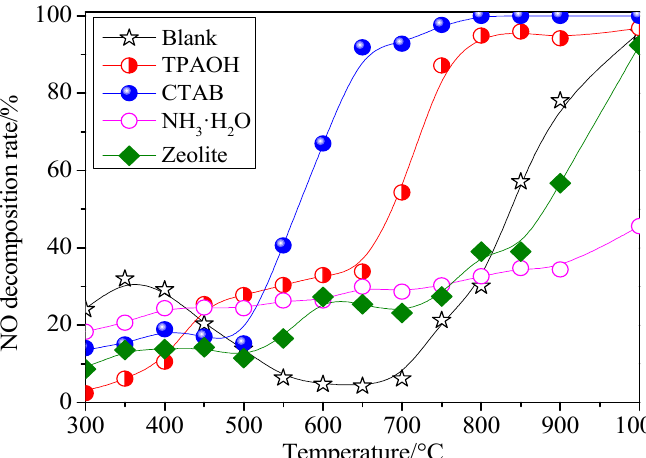
Figure 2. The effect of porous materials with different templates on the NO decomposition rate (Blank, tetrapropylammonium hydroxide (TPAOH), cetyltrimethylammonium bromide (CTAB), ammonium tetrapropylammonium hydroxide (TPAOH), cetyltrimethylammonium bromide (CTAB), hydroxide (NH 3 ·H 2 O), and Zeolite were used, respectively, instead of the Cu-Al/SiO 2 porous materials with no template added, TPAOH, CTAB, NH 3 ·H 2 O, and zeolite seed crystal).